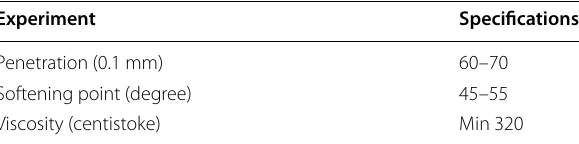
Table 2 Specifications of the bitumen used (The Egyptian code for urban and rural roads (ECP, 2008) part (4)) [33] Experiment Specifications